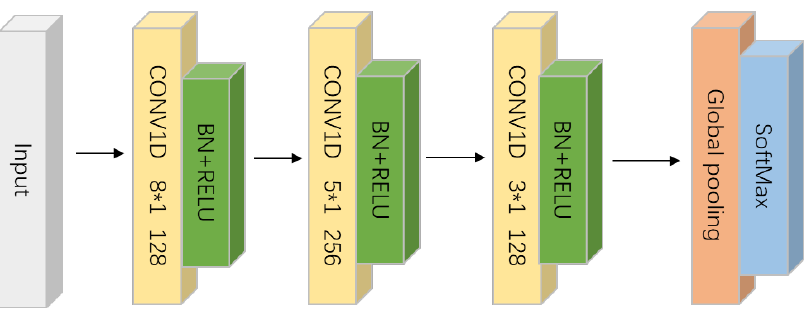
Figure 3. The commonly used structure of FCN in TSC field.